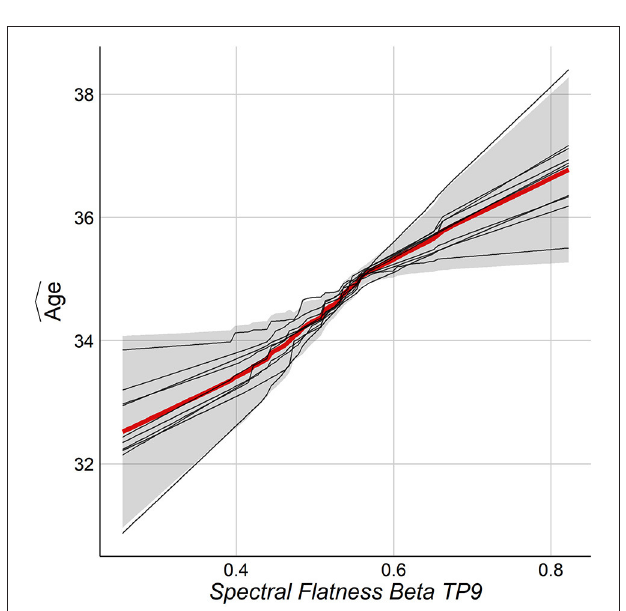
FIGURE 8 | PDP for the top feature from NCV from Stack-Ensemble